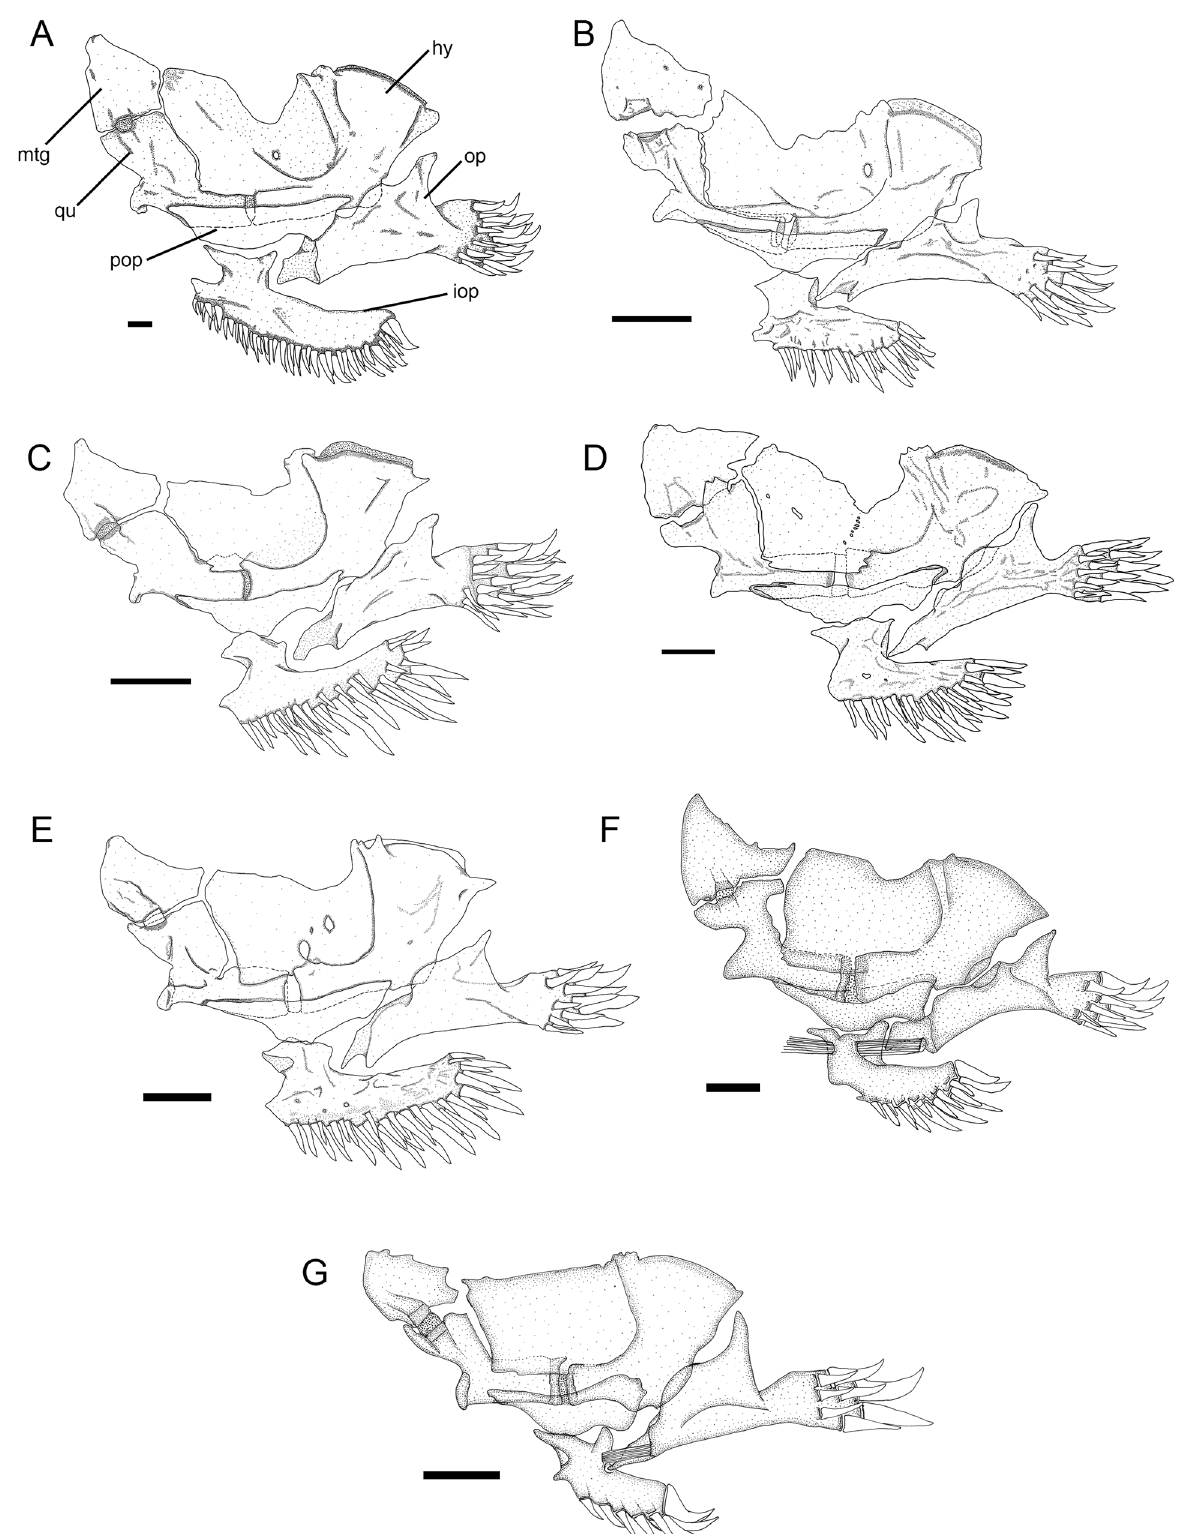
Figure 5. Left suspensory in dorsal view. A Trichomycterus giganteus , UFRJ 5732, paratype. B Cambeva davisi , UFRJ 10713. C Trichomycterus alternatus , UFRJ 5673. D Cambeva zonata , UFRJ 11900. E Trichomycterus brasiliensis , UFRJ 4834. F Cambeva brachykechenos , UFRJ 10586. G Scleronema operculatum , UFRJ 11856. Scale bar: 1 mm hy, hyomandibula; iop, interopercle; mtg, metapterygoid; op, opercle; pop,